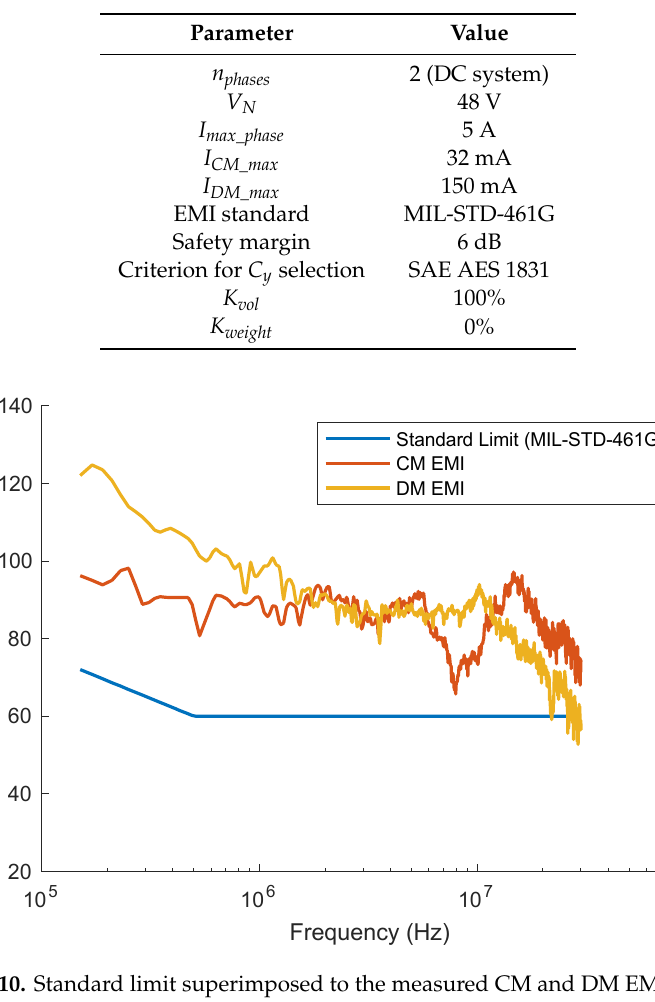
Table 3. Results obtained in the three scenarios for the chosen case study.